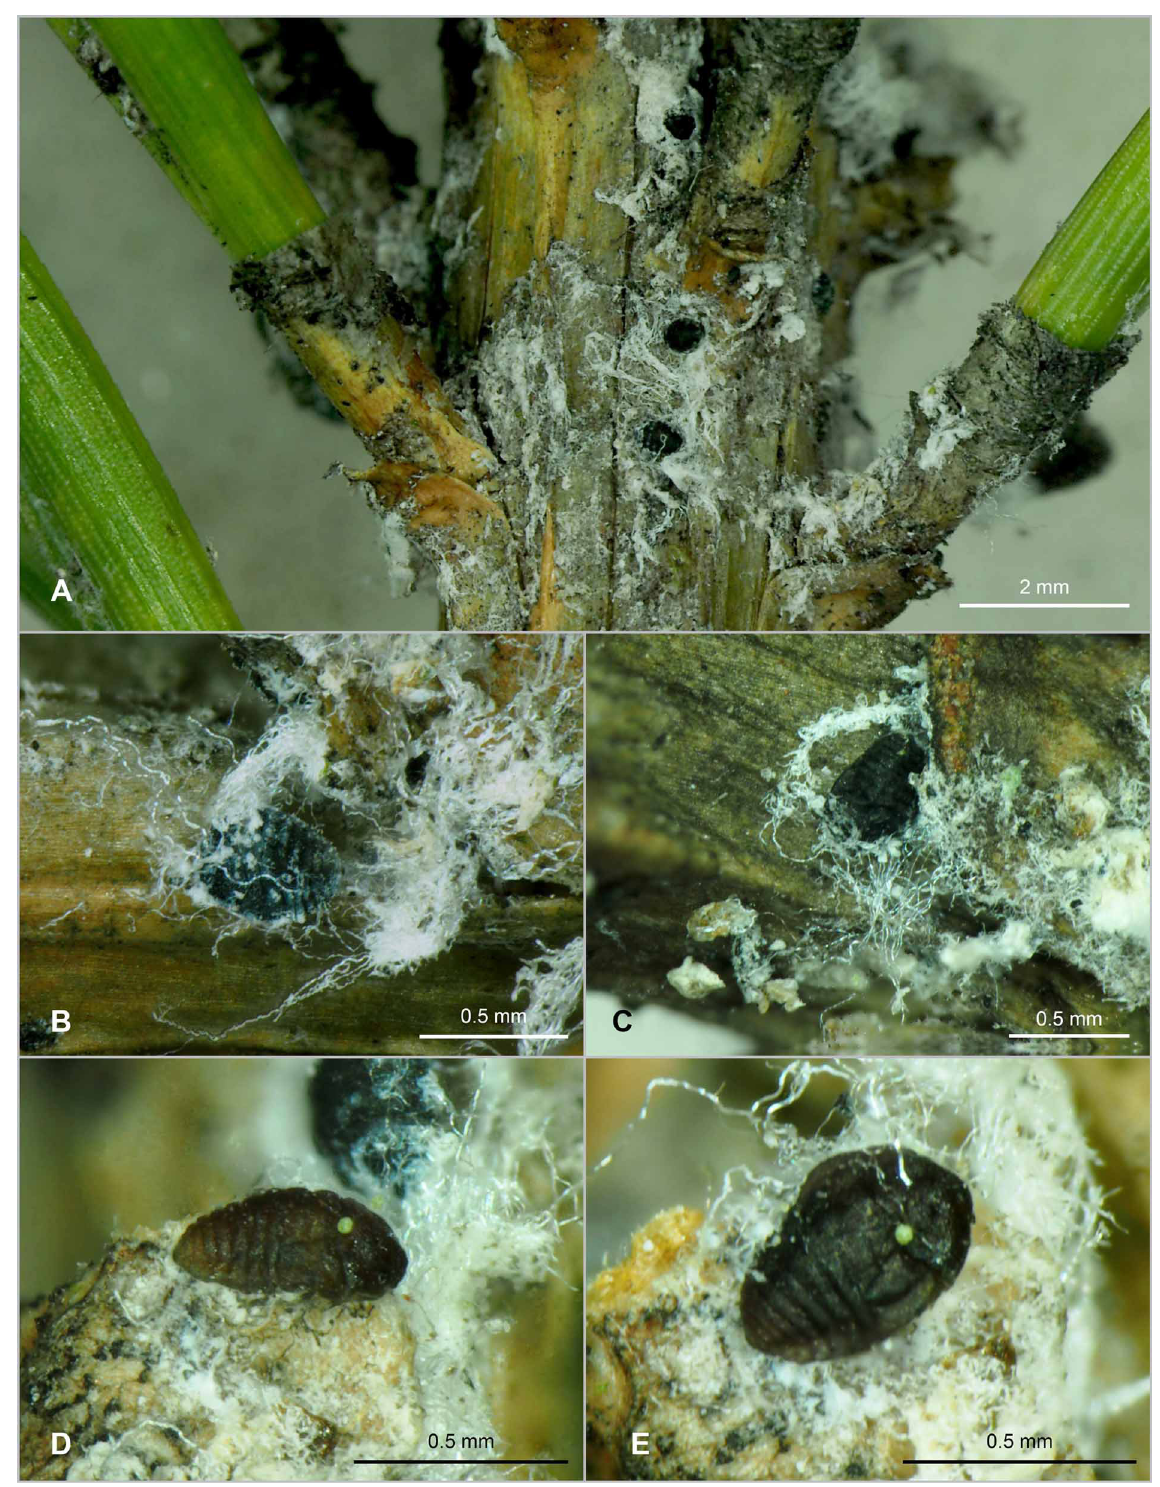
Fig. 74. Pineus (Pineus) pini (Macquart, 1819) on Pinus sylvestris in winter. A . Colony in top of dwarfish plant growing on exposed rock. B . Juvenile aptera. C–E . Juvenile alatae, excess wax wool and covering bark flakes